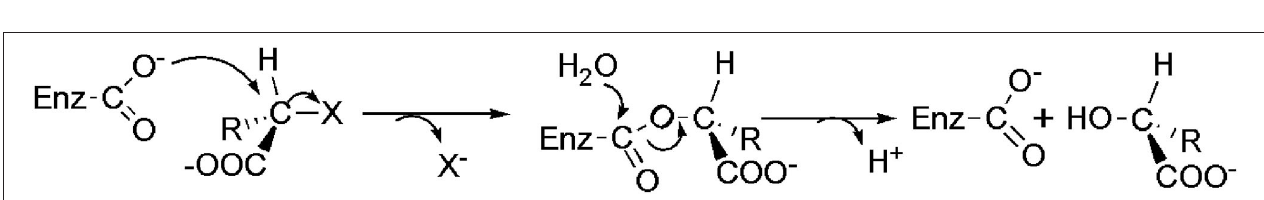
FIGURE 1 | L-DEX structures. (A) Structural superposition of DhlB (hotpink, PDB ID: 1qq5) and L-DEX YL (green, PDB ID: 1jud). (B) Structural superposition of DhlB (hotpink, PDB ID: 1qq5), L-DEX YL (green, PDB ID: 1jud), PH0459 (cyan, PDB ID: 1x42), DehIVa (magenta, PDB ID: 2no4), DehSft (yellow, PDB ID: 2w11) and DehRhb (salmon, PDB ID: 2yml).